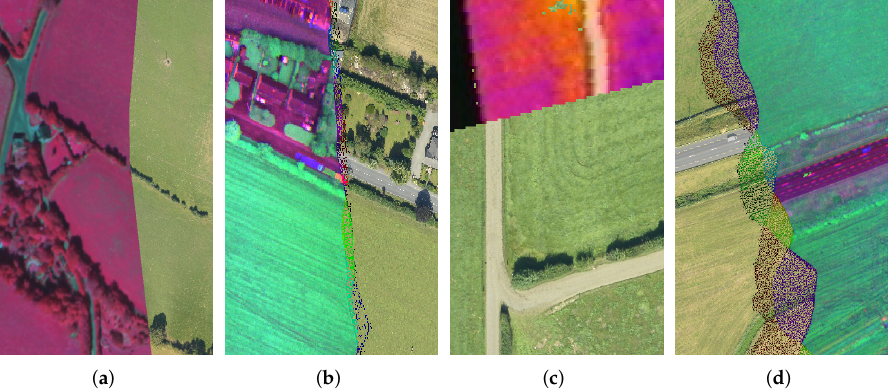
Figure 10. Image fusion accuracy assessment; ( a ) seamless joining of boundaries between RGB and multispectral imagery; ( b ) high accuracy in the northern element of the image when comparing hyperspectral with RGB; ( c ) large errors in the south of the thermal image; ( d ) errors visible for hyperspectral in the south